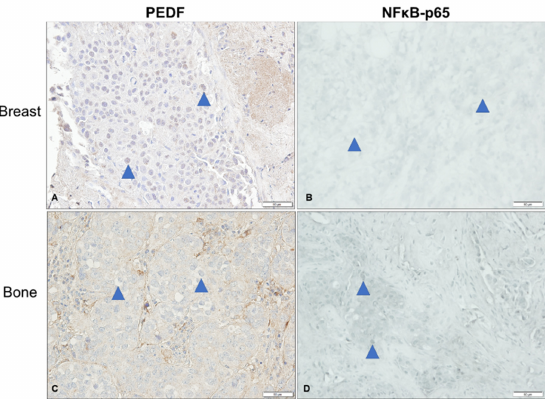
Figure 5. Immunohistochemistry analysis of PEDF and p-NF κ B-p65 expression in ER+/HER2- breast cancer and bone metastases tissue. Microscope images of untreated oestrogen receptor positive (ER+)/human epidermal growth factor receptor-2 negative (HER2-) primary breast cancer (BC) and bone metastases patient tissue specimens, stained via immunohistochemistry (IHC) for phosphorylated (p-)NF κ B-p65 expression (blue stain), compared with PEDF expression (brown stain) of a small subset of samples as previously determined by our group [19]. PEDF expression was determined in the same cohort of tissue specimens as previously published by our group [19], here we revisited a small sub-set of these samples and additionally stained for NF κ B-p65 via IHC using the same scoring technique previously described [19]. PEDF (brown) stained BC cells in breast ( A ) and bone ( C ), and NF κ B-p65 stained (blue) in BC cells in breast ( B ) and bone ( D ). Blue arrows indicate invasive BC cells. Scale bar, 50 µ